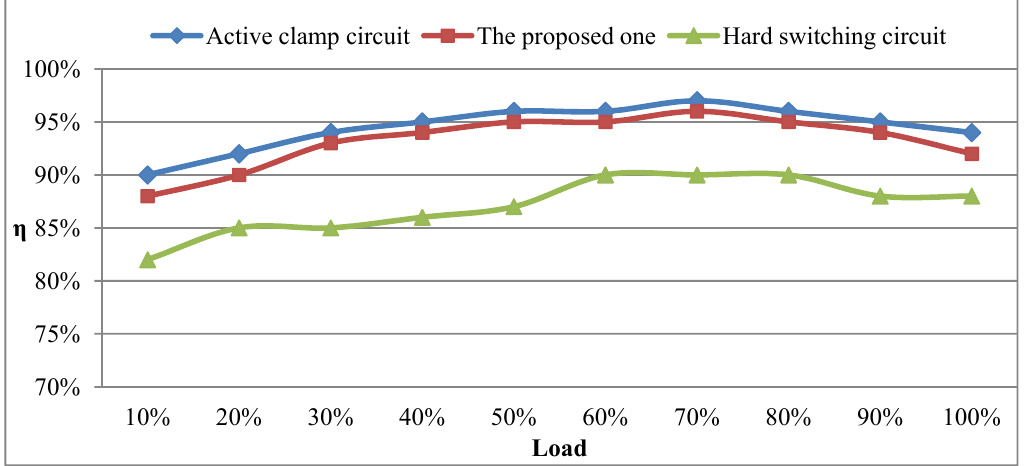
Figure 27. Comparison conversion efficiency among the interleaved active clamp boost converter with hard-switching circuit, active clamp circuit and the proposed